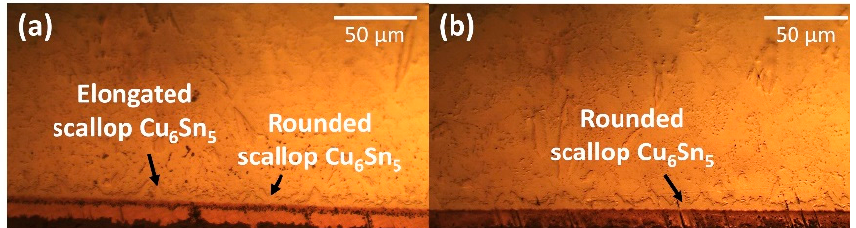
Figure 6. Cross-sectional as-reflowed optical microscope images for ( a ) non-reinforced SAC305 and ( b ) SAC305-KGC composite solder.